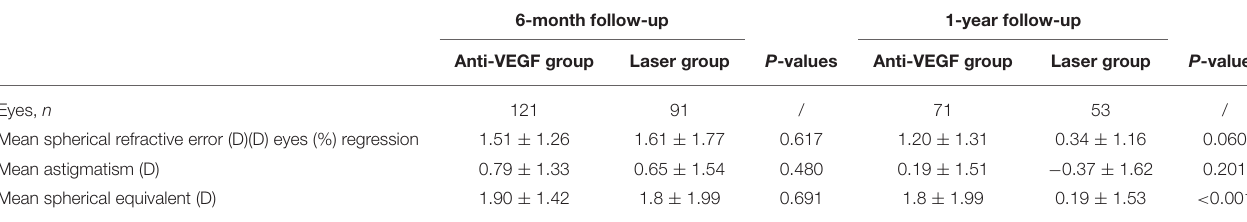
TABLE 4 | Comparison of refractive errors between ROP patients treated with anti-VEGF and